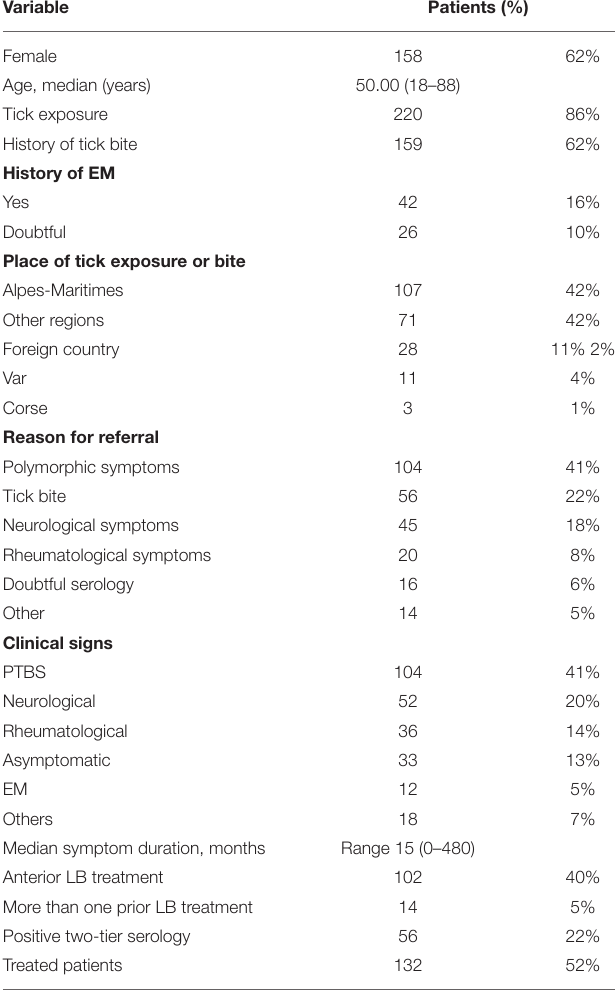
TABLE 1 | Patients